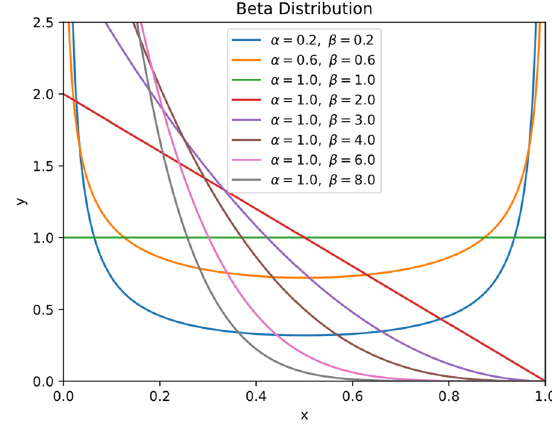
Figure 3. Beta distribution with different parameters.